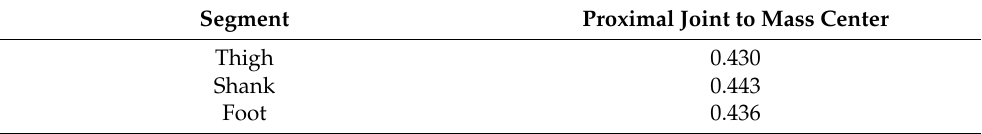
Table 1. Parameters for proportional distance from the proximal joint to the segmental mass center.